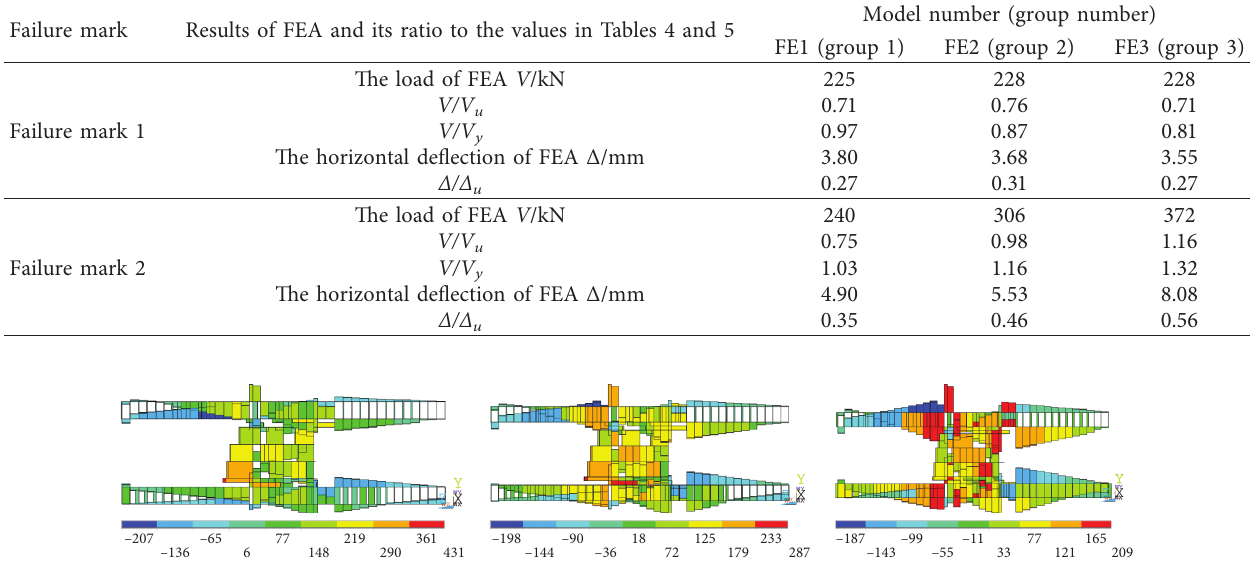
the primary compressive stress of concrete, which is consistent with the experimental results in Figure 19. Combined with the above analysis, the FE models under failure mark 1 are reliable and the results of FEA have reference value.